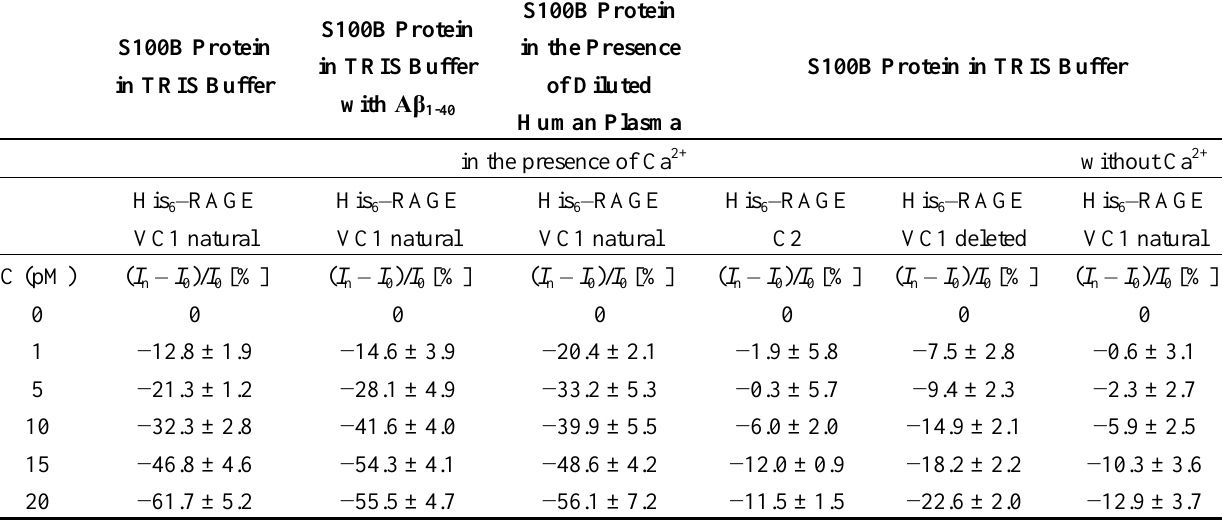
Table 1. The relative Cu(II) redox changes (%) current measured with electrodes incorporating His –RAGE domains (VC1, VC1 deleted and C2) after incubation with 6 S100B solution. ( I is the current measured in the presence on a particular S100B n concentration, I is the current measured in buffer with no 0